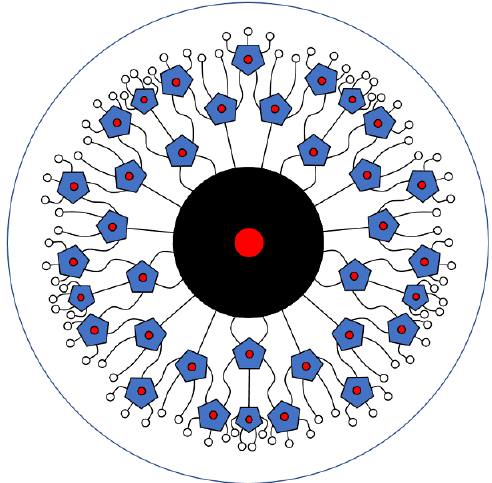
Figure 8 . A pentagon code with a black hole in the centre. The black hole is modelled as a large random tensor with a single D -dimensional dangling leg creating the space of allowed microstates and n tot d -dimensional legs (cid:13)owing into the network. The remaining tensors are all perfect tensors with a single dangling d -dimensional leg that forms the bulk degrees of freedom and 5 d -dimensional legs (cid:13)owing into the